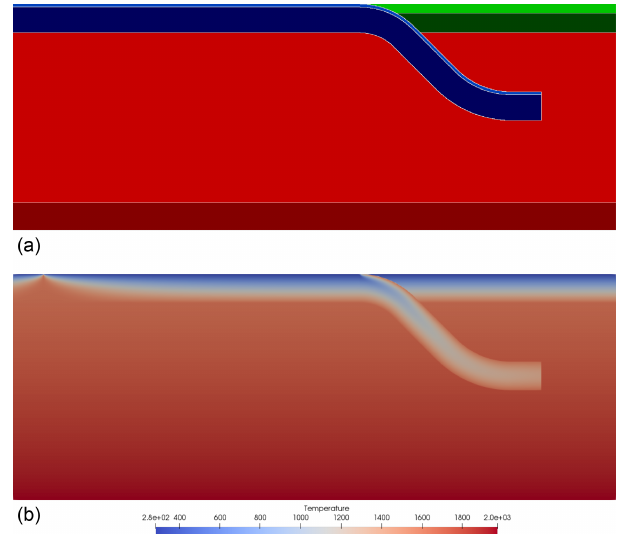
Figure 1. se-2019-24Panel (a) shows the distribution of different compositions through the model domain. The oceanic crust com- position is light blue, the oceanic lithosphere is dark blue, the continental crust is light green, the continental lithosphere is dark green, the upper mantle is light red, and the lower mantle is dark red. Panel (b) shows the temperature distribution (in Kelvin) in the model.